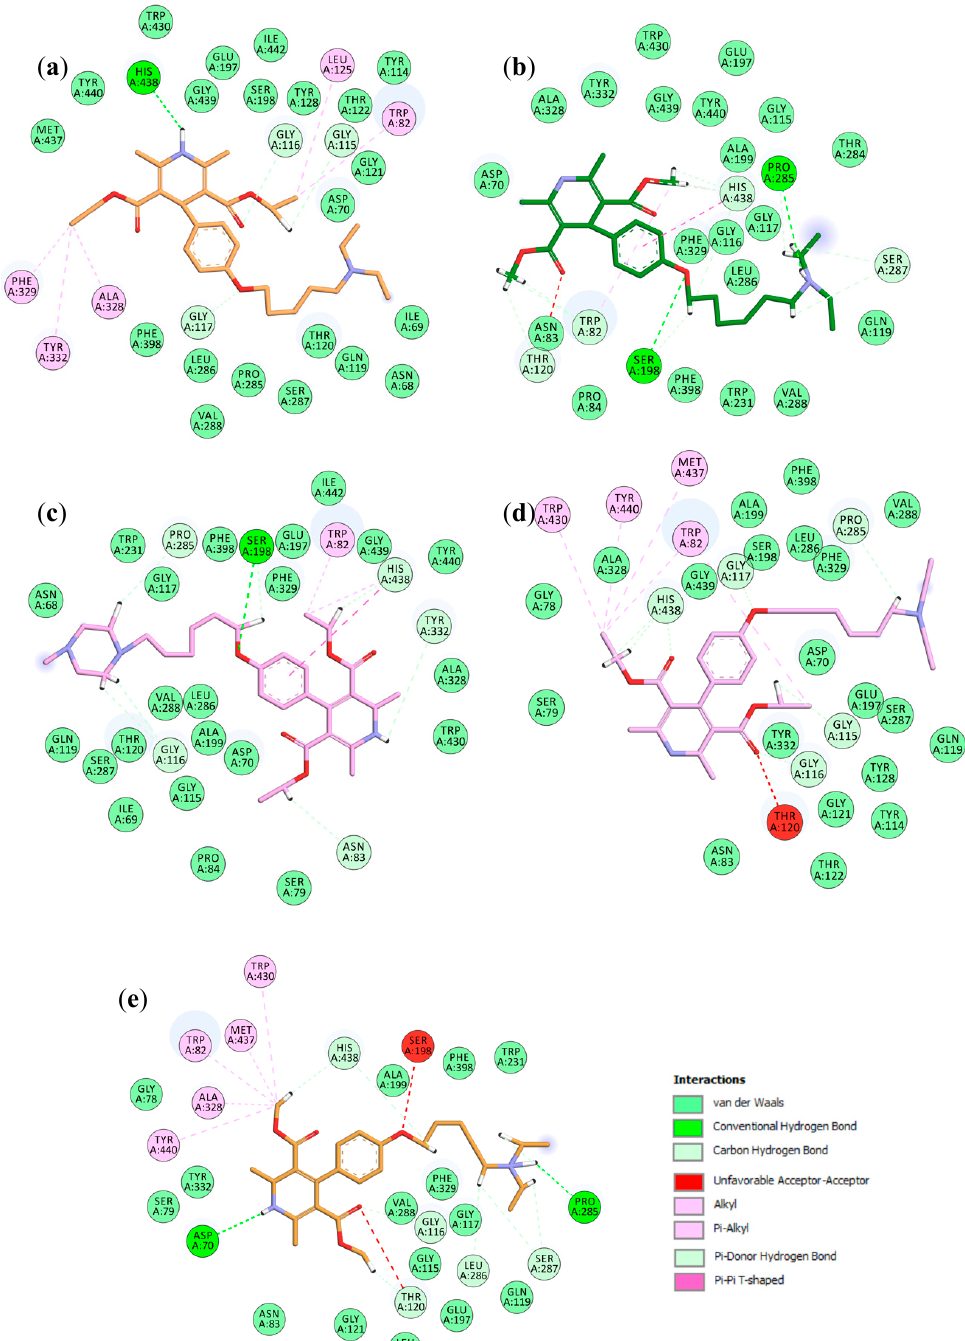
Figure 6. Two-dimensional schematic view of the interactions between 3c ( a ), 3l ( b ), 3m ( c ), 3k ( d ), 3d ( e ) and hBChE.